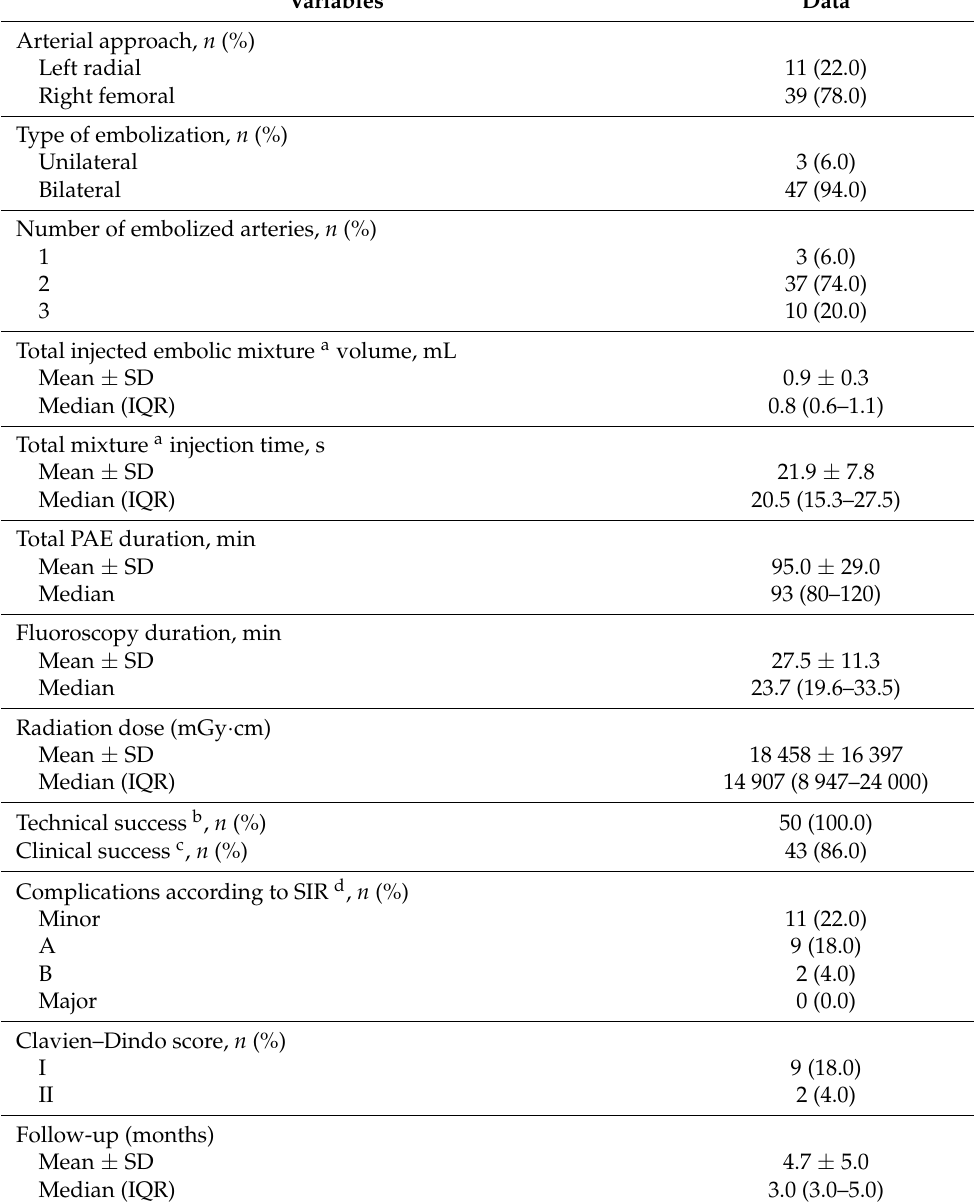
Table 2. Technical features of PAE and short-term safety